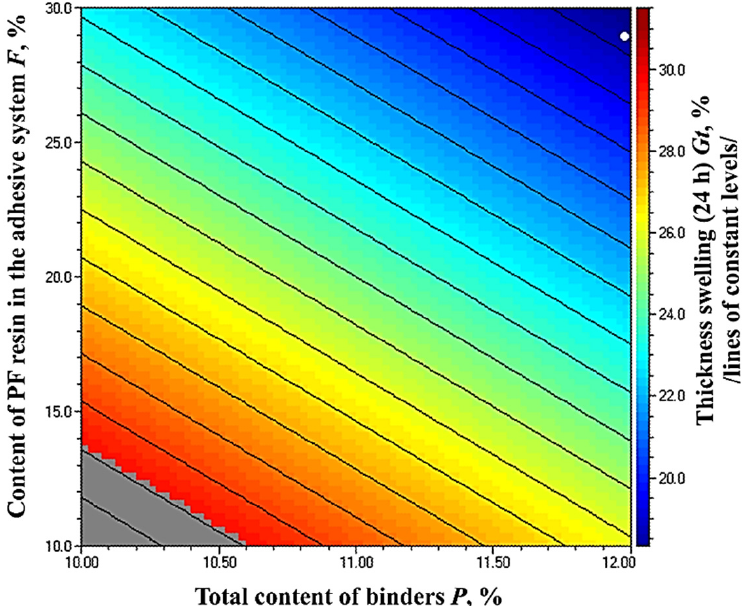
Figure 10. Effect of binder content and PF resin content in the adhesive system on the TS of fiberboard panels.